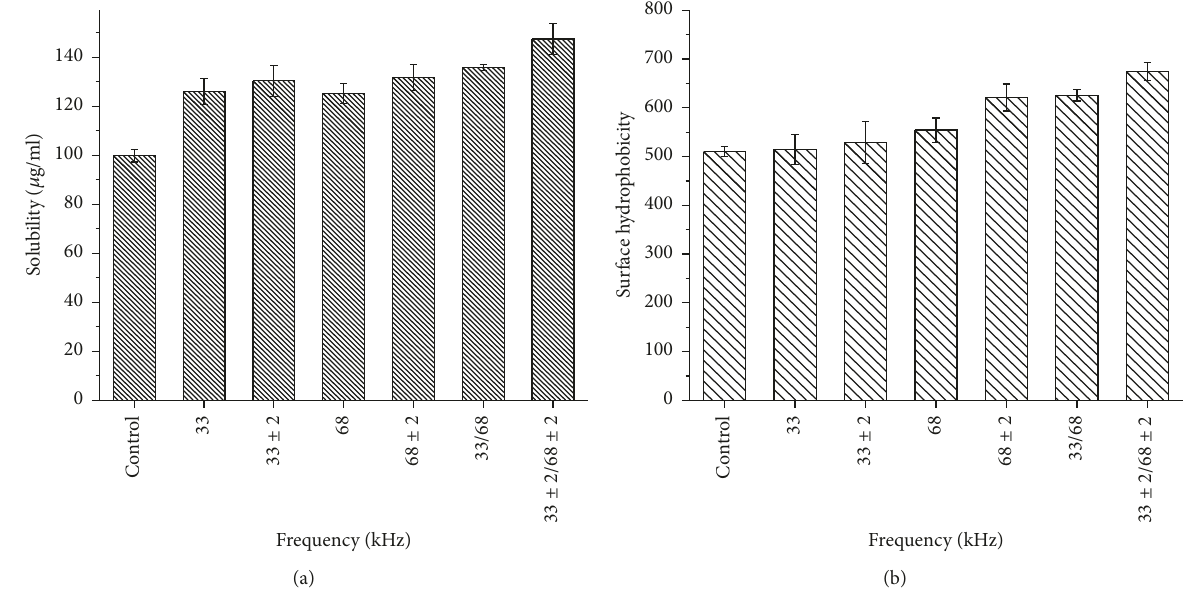
Figure 4: Effects of pretreatment with ultrasound bath with four different working modes and two frequencies on the solubility (a) and surface hydrophobicity (b) of